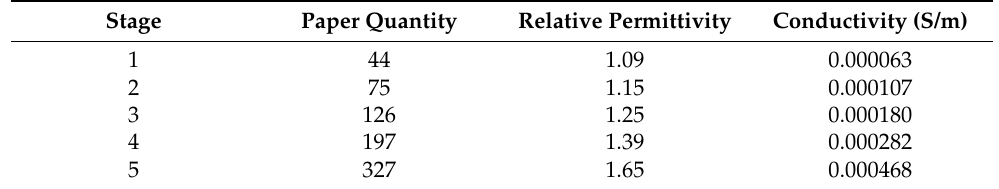
Table 1. Quantity, permittivity, and conductivity per stage.